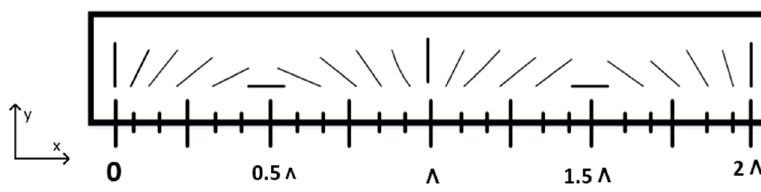
Figure 1. Structure of a monolithic LCPG.